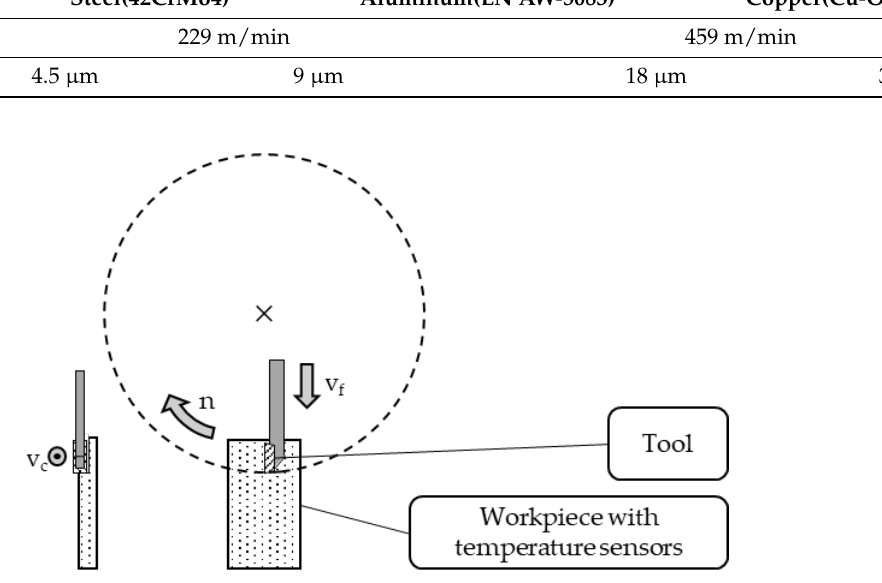
Figure 4. Schematic representation of the fly-cutting process. To validate the measurements of the newly developed sensors, a variation of the machining process was performed to ensure varying temperatures. The workpiece material was altered between steel (42CrMo4), aluminum (EN AW- 5083), and copper (Cu-OF). Another variation in resulting temperatures was realized variating the process parameters cutting speed and feed according to Table 1. Variation of workpiece materials and process parameters.